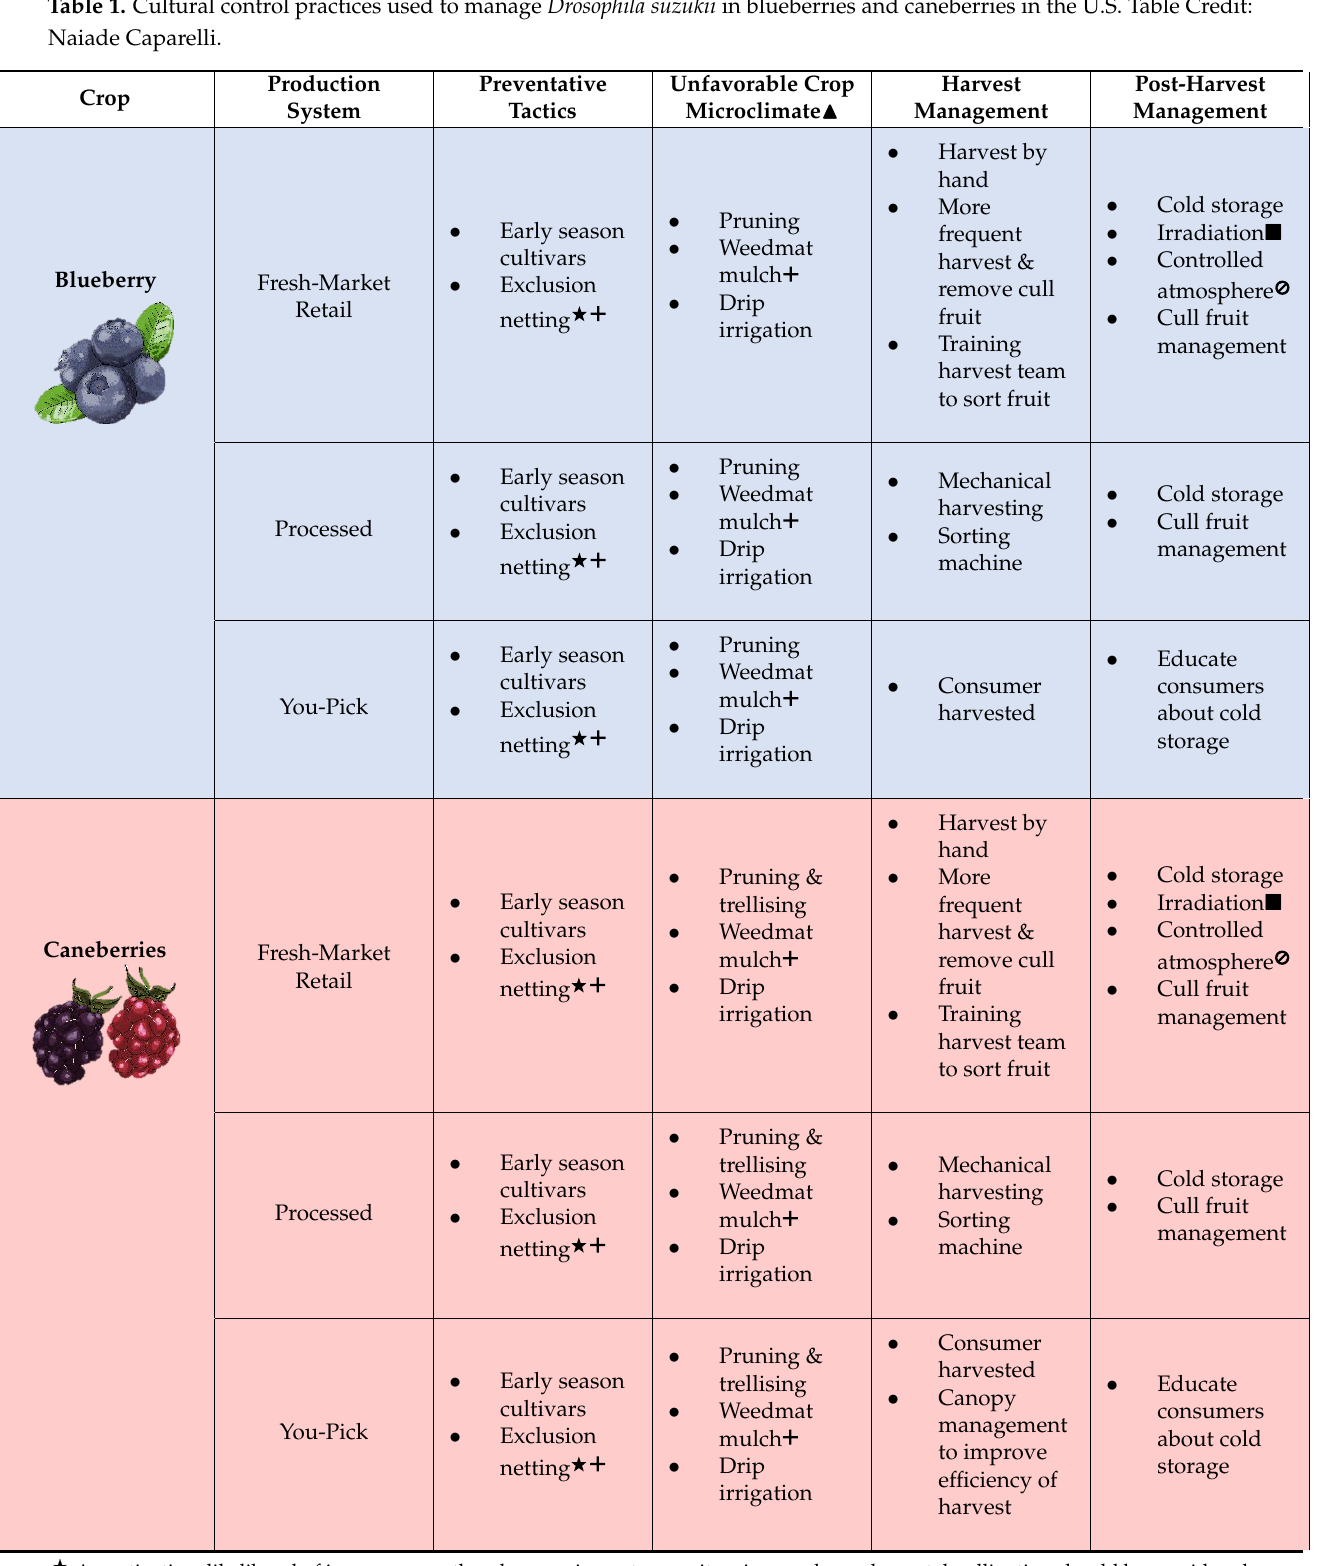
Table 1. Cultural control practices used to manage Drosophila suzukii in blueberries and caneberries in the U.S. Table Credit: Naiade Caparelli.